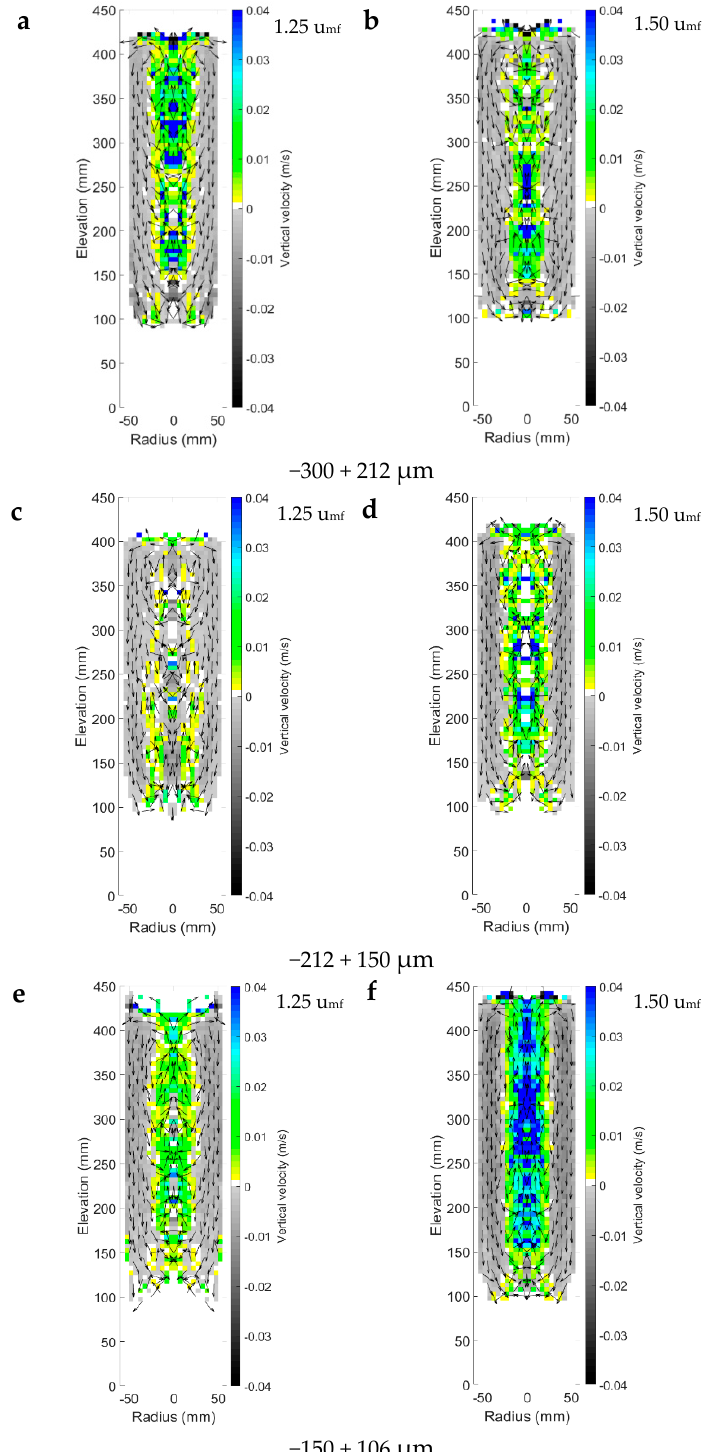
Figure 2. Vertical velocities of the activated quartz particle in each fluidized bed for an airflow rate of 1.25 u mf ( left column ) and 1.50 u mf ( right column ) for decreasing particle size ( top to bottom ). ( a ) − 300 + 212 µm at 1.25 u mf ; ( b ) − 300 + 212 µm at 1.50 u mf ; ( c ) − 212 + 150 µm at 1.25 u mf ; ( d ) − 212 + 150 µm at 1.50 u mf ; ( e ) − 150 + 106 µm at 1.25 u mf ; ( f ) − 150 + 106 µm at 1.50 u mf . Different to the coarser-sized bed ( − 300 + 212 µm), Figure 2c shows that, at a lower airflow rate (1.25 u mf ), the − 212 + 150 µm bed starts to descend in the center and ascend between the center and the wall. However, according to Figure 2d, under a higher airflow